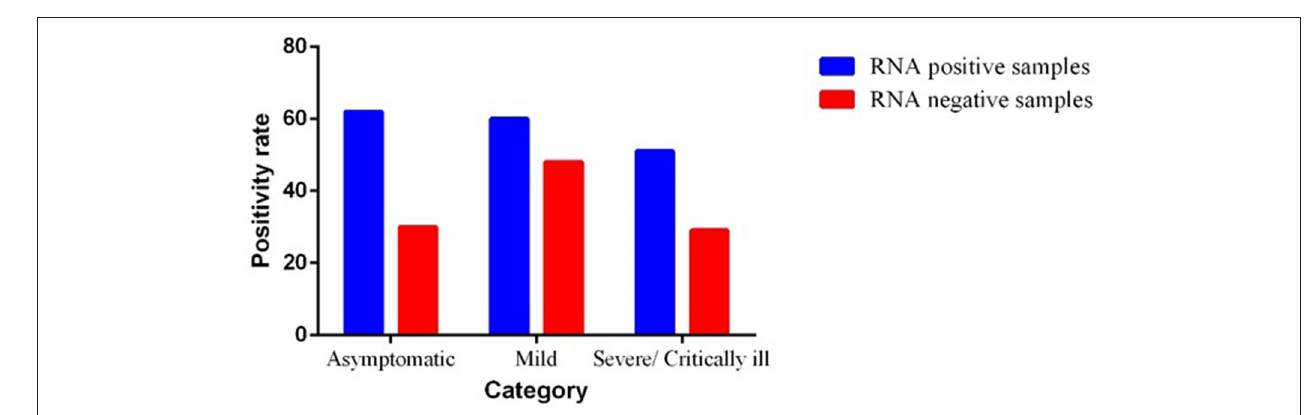
FIGURE 2 | Severity of illness in severe acute respiratory syndrome coronavirus 2 (SARS-CoV-2) infected